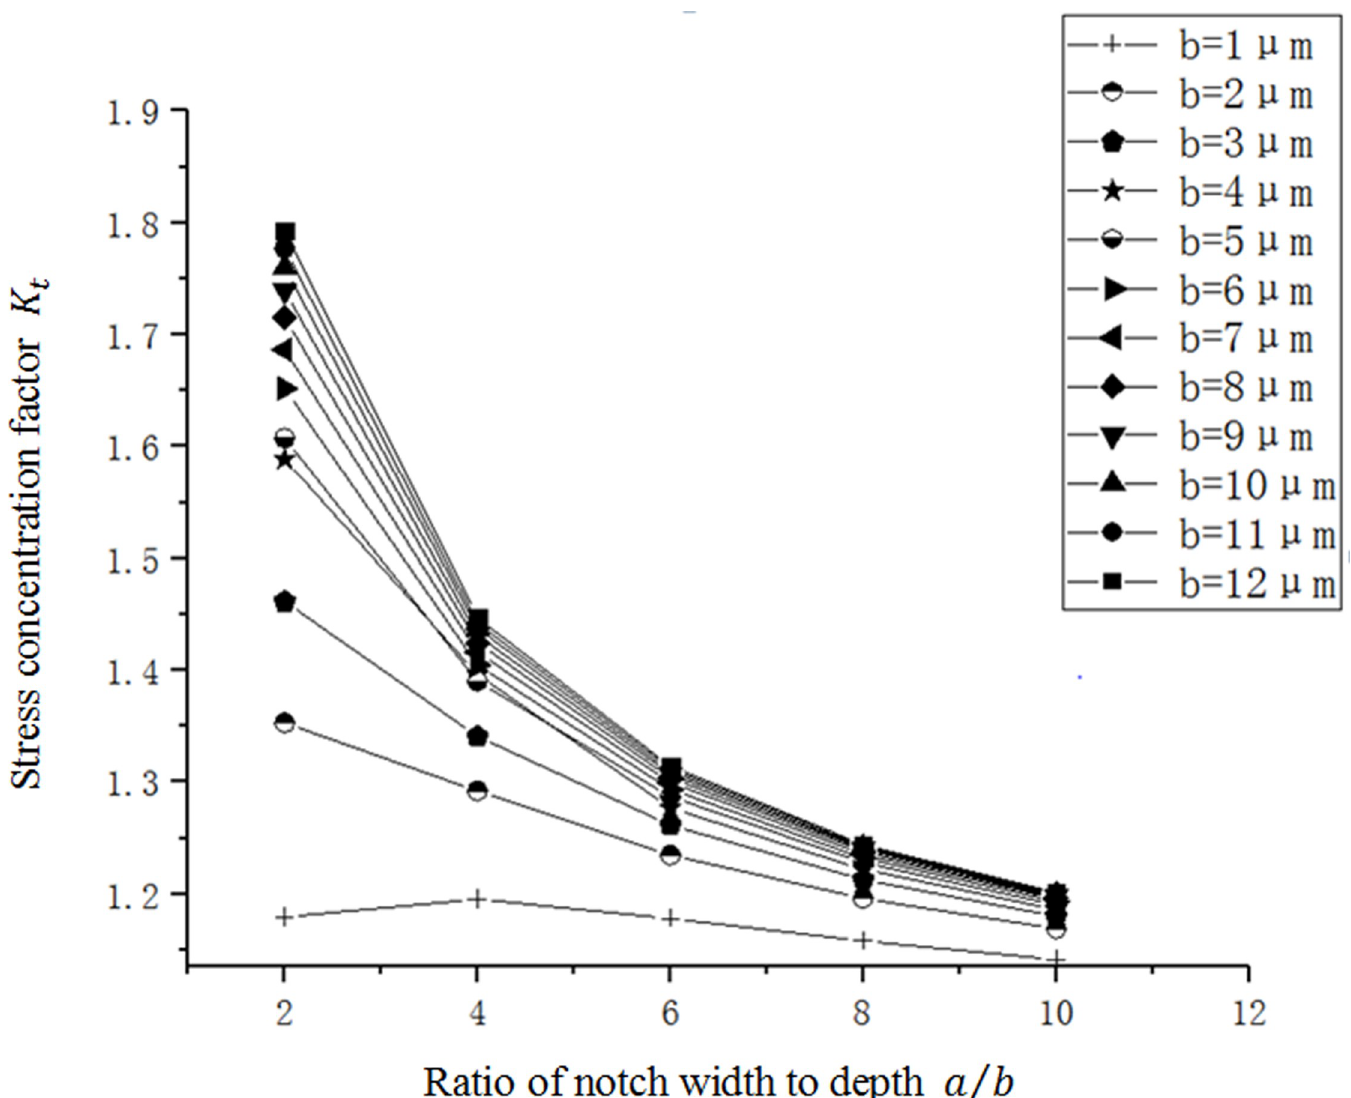
Fig 8. The relation curve between K